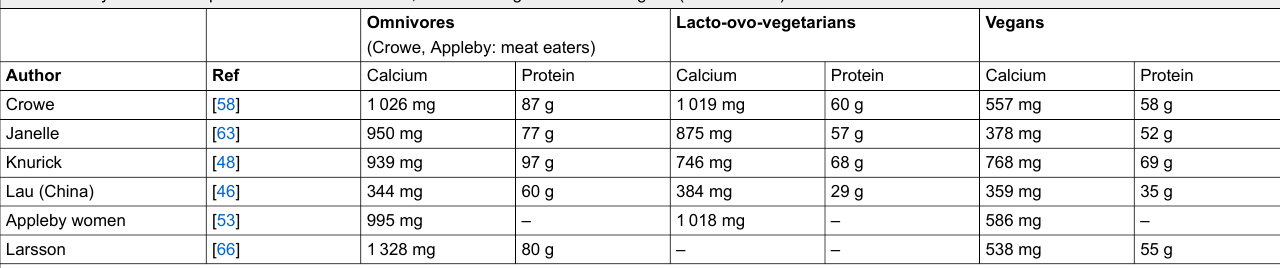
Table 1 : Daily calcium and protein intake of omnivores, lacto-ovo-vegetarians und vegans (mean values). Omnivores (Crowe, Appleby: meat eaters)